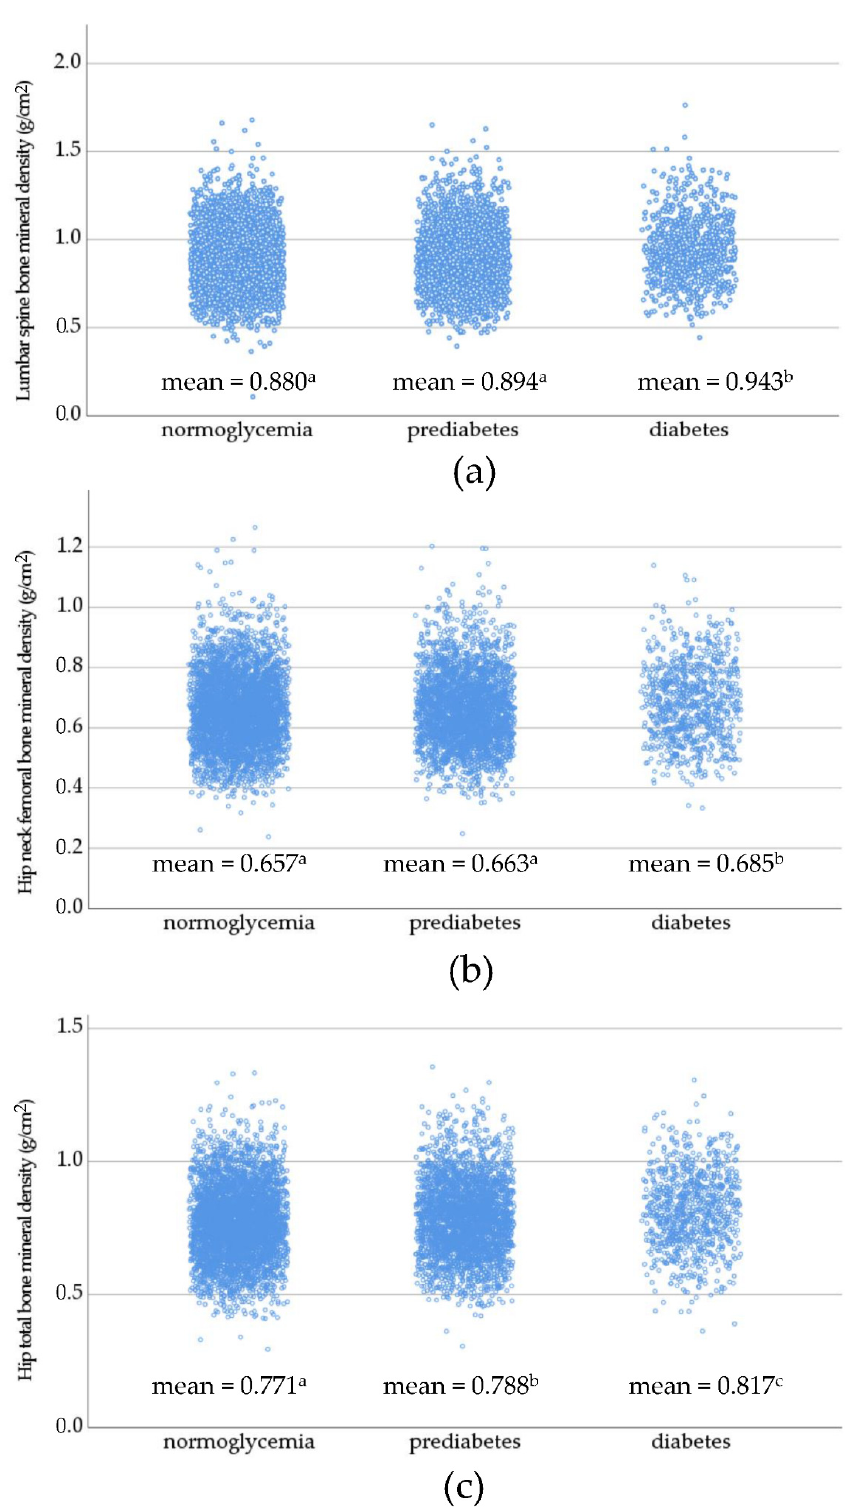
Figure 2. Scatterplot of lumbar spine bone mineral density ( a ); hip neck femoral bone mineral density ( b ); and hip total bone mineral density ( c ) in the normoglycemia, prediabetes, and diabetes group. The means were compared using analysis of variance with Bonferroni adjustment for pairwise comparisons. Different superscript denotes statistically significant differences between group means ( p <